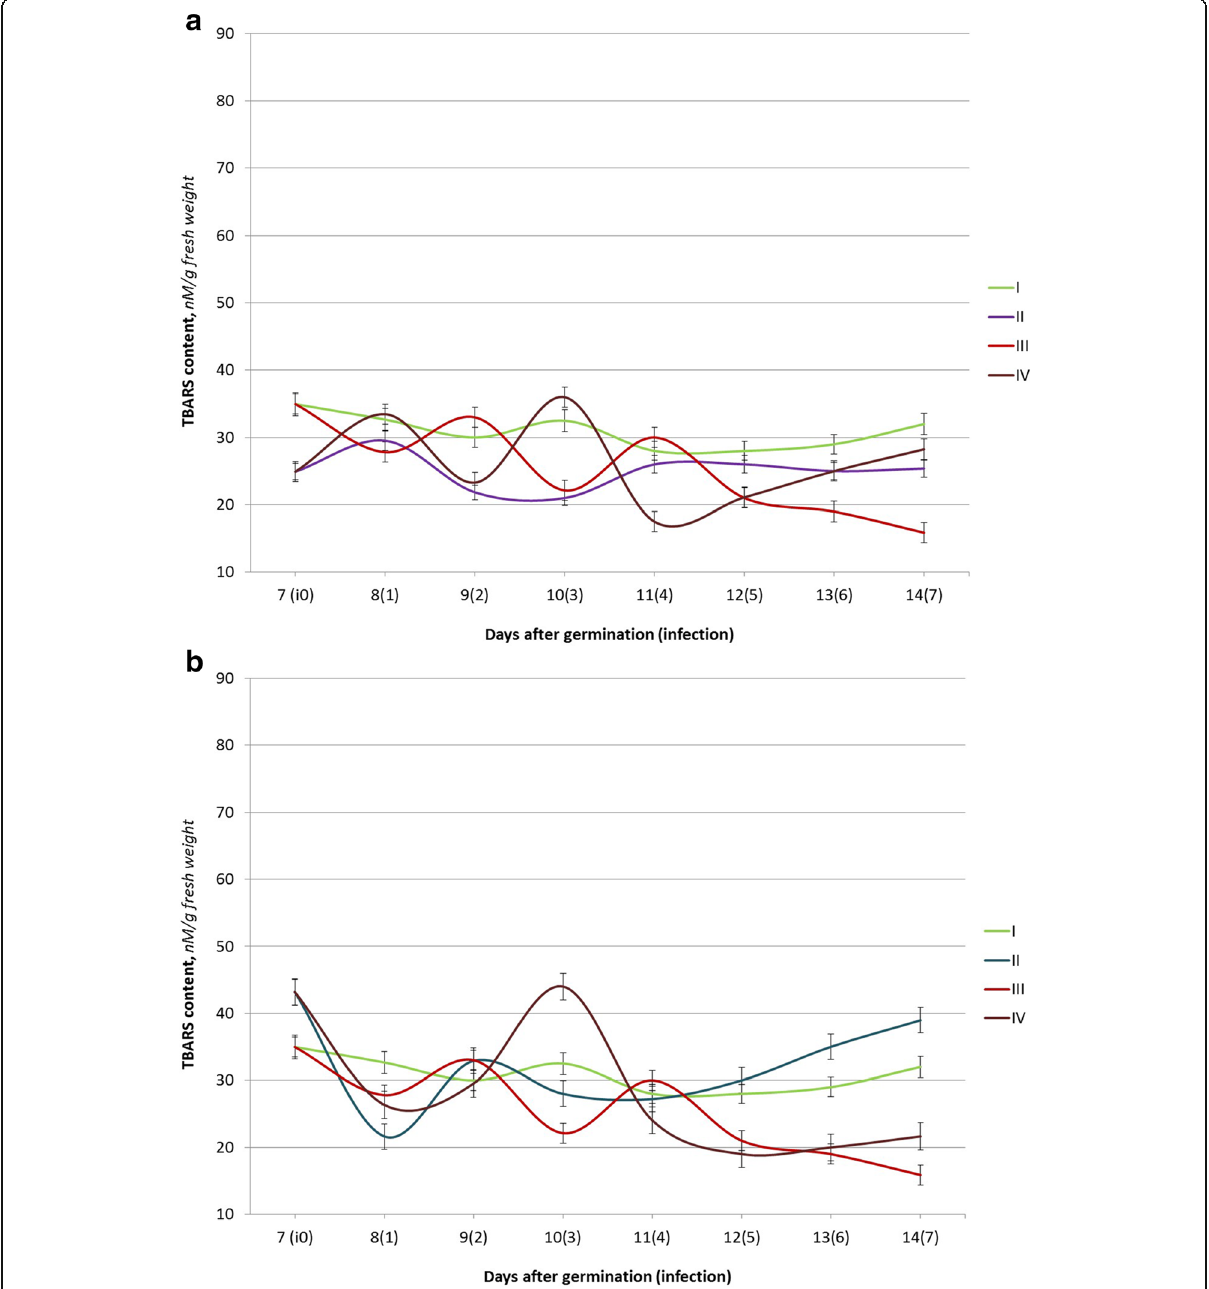
Fig. 3 The TBARS content of seedlings of winter wheat (the Renan variety) under the action of Ag ( a ) or Cu ( b ) nanoparticle solutions and P. herpotrichoides infection: I control plants (w/o infection); II seed treatments with Ag ( a ) or Cu ( b ) nanoparticle solutions; III P. herpotrichoides infection; IV P. herpotrichoides infection + treatments with Ag ( a ) or Cu ( b ) nanoparticle